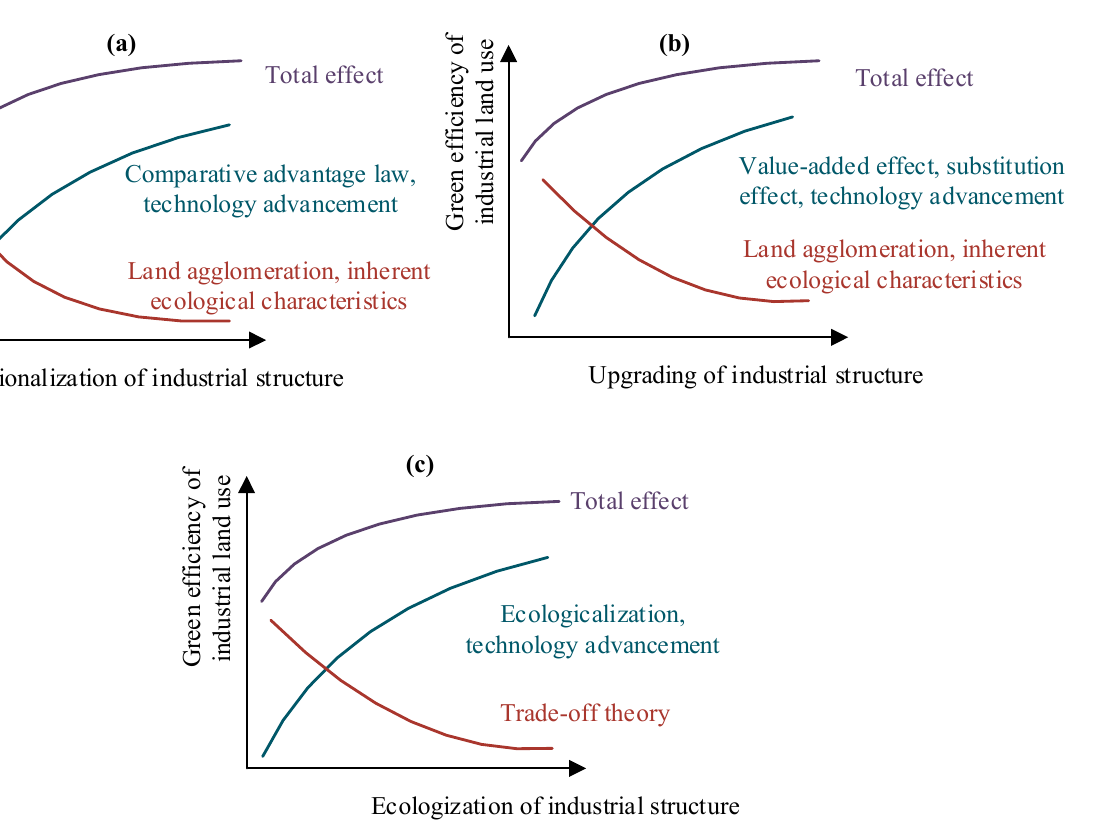
Figure 2. The effect mechanisms of industrial structure optimization on green efficiency of industrial land use. ( a – c ) show the effect mechanisms of RIS, UIS, and EIS on GEILU, respectively.